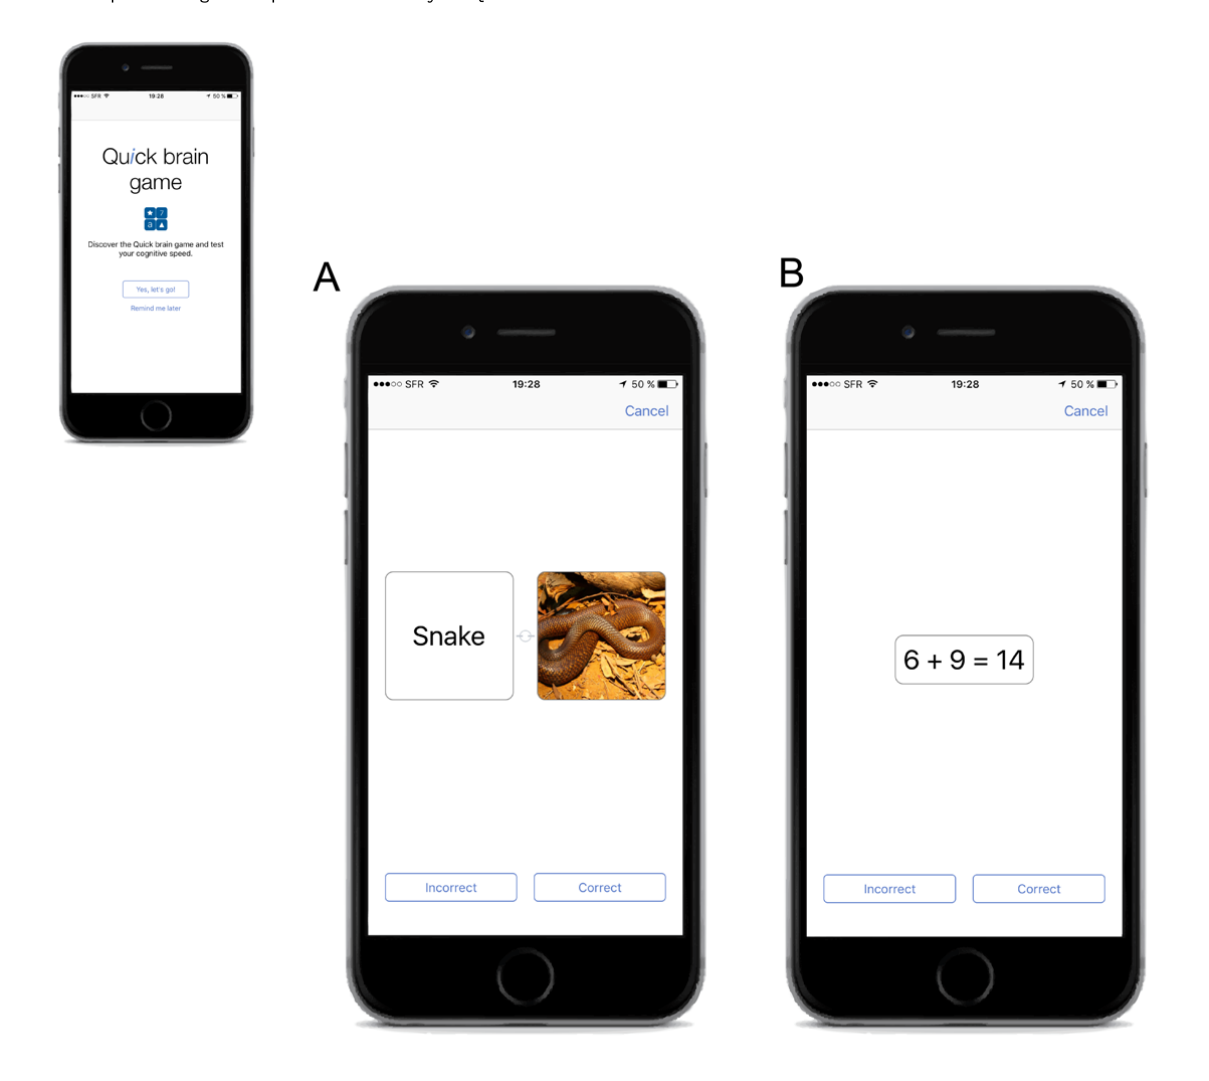
Figure 1. Example of a cognitive speed assessment by the QU i CKBRAIN